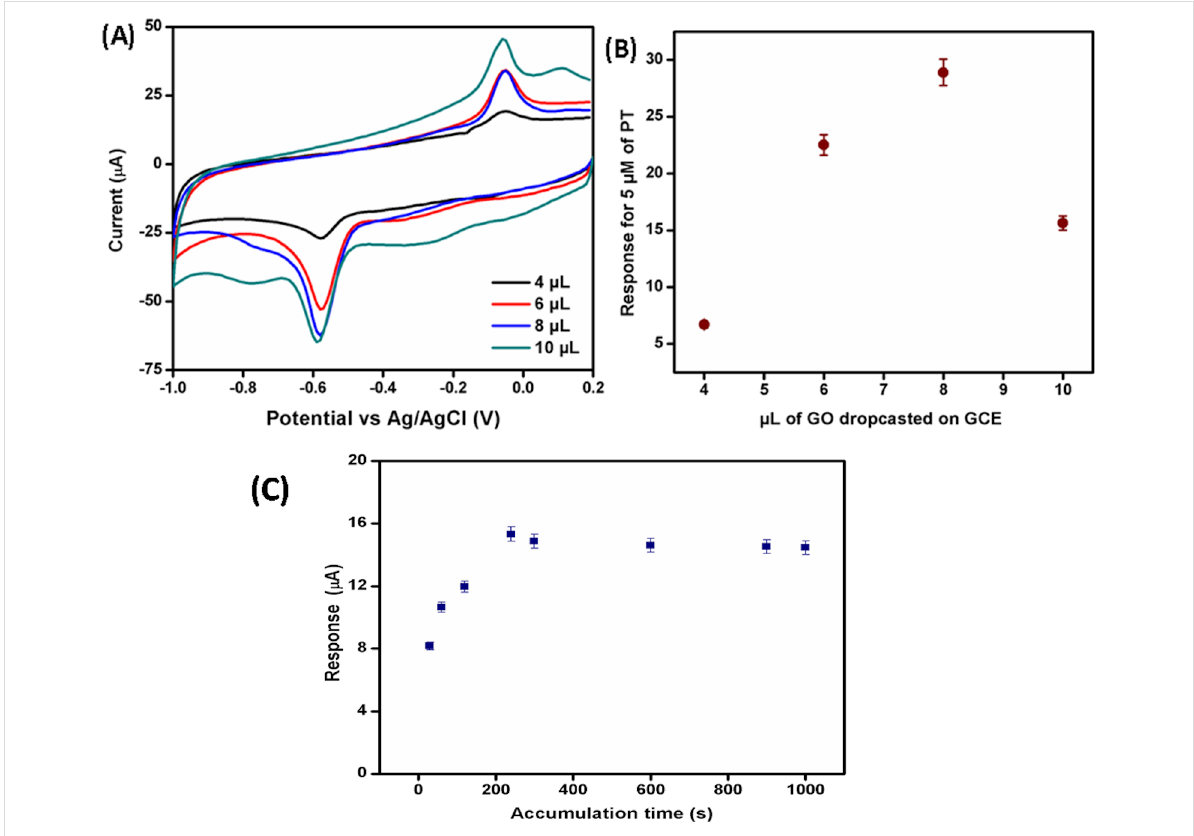
Figure 6: (A) Cyclic voltammograms of 10 μ M PT in PBS, pH 7, with different amounts of GO deposited on bare GCE for the preparation of modified ERGO/GCE. (B) Peak current of cyclic voltammetry using 10 μ M PT with different amounts of GO deposited on bare GCE for preparation of modified ERGO/GCE. (C) Peak response of 10 μ M PT with variation of the accumulation time before voltammetric